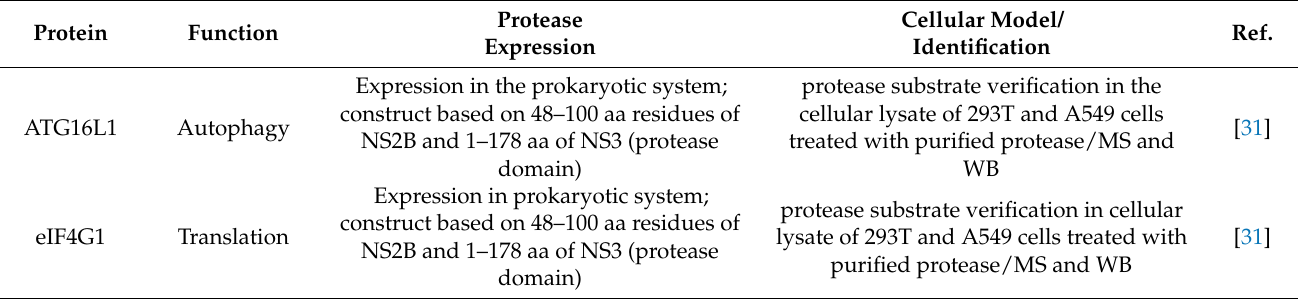
Table 1. Reported NS3 protease targets in the cell. Abbreviations: MS—mass spectrometry, WB—Western blotting. Protein